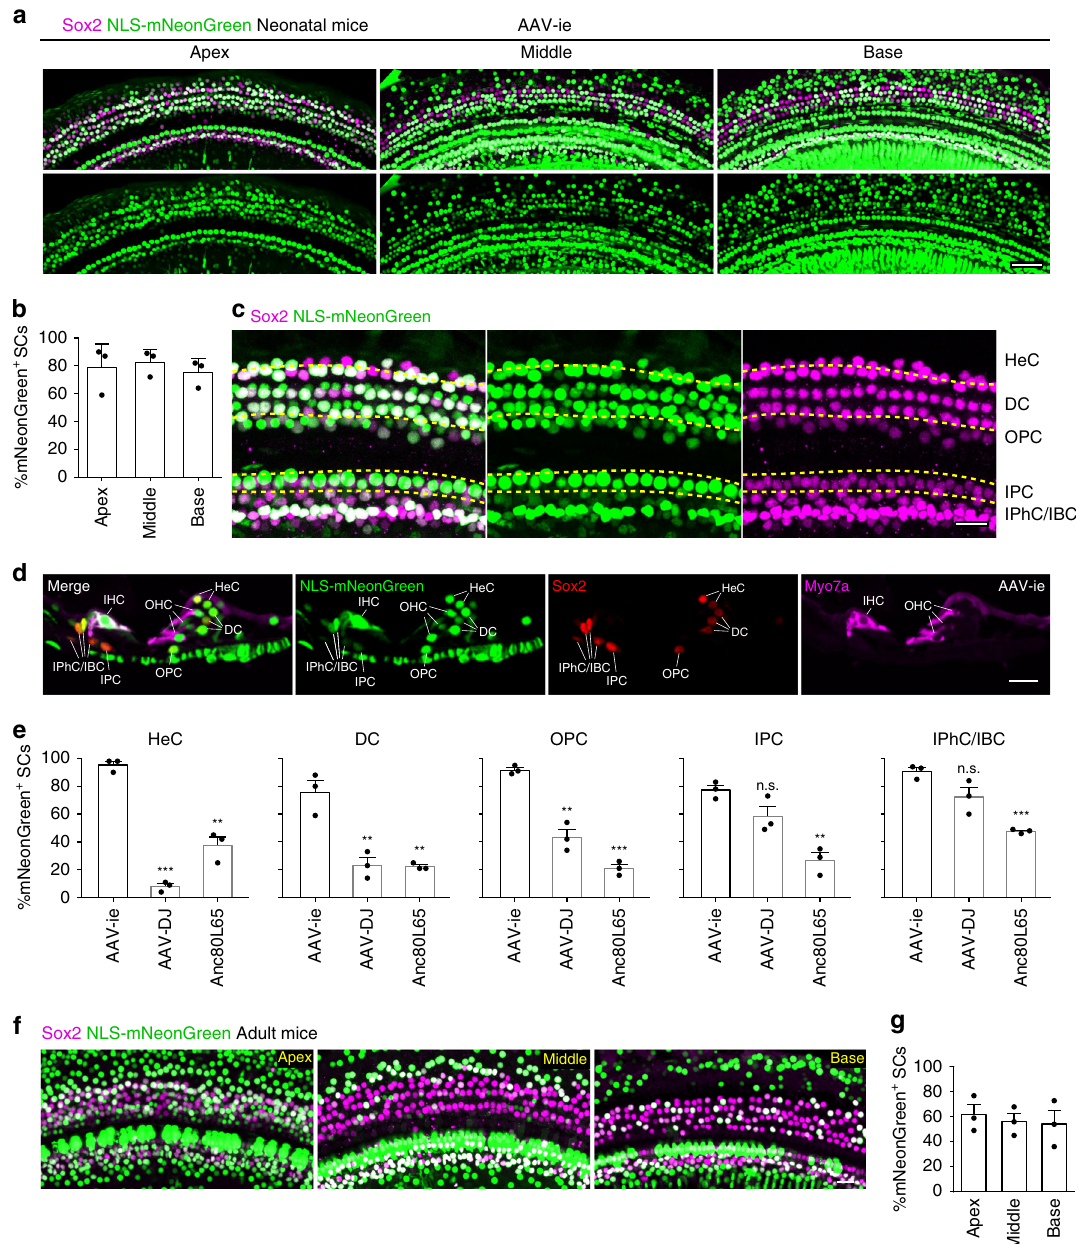
Fig. 2 Adeno-associated virus-inner ear (AAV-ie) ef fi ciently targets cochlear supporting cells in neonatal and adult mice. a Images of the apical, middle, and basal turns of cochlea injected at P3 with AAV-ie-NLS-mNeonGreen (nuclear localization sequence-mNeonGreen) at a dose of 1 × 10 10 genome- containing (particles) (GCs) per ear. Green: NLS-mNeonGreen; magenta: Sox2. Scale bar, 50 µ m. b Percentage of NLS-mNeonGreen-positive supporting cells (SCs) per 100 µ m corresponding to a . Data are shown as mean ± SEM. N = 3 mice. Source data are provided as a Source Data fi le. c Confocal images of Hensen ’ s cells (HeCs), Deiters cell (DCs), outer pillar cells (OPCs), inner pillar cells (IPCs), inner phalangeal cell (IPhCs), and inner border cell (IBCs) in apical turn of cochleae injected with AAV-ie-NLS-mNeonGreen. Green: NLS-mNeonGreen; magenta: Sox2. Scale bar, 20 µ m. d Cross-section of AAV-ie- NLS-mNeonGreen injected cochlea (1 × 10 10 GCs per ear). Green: NLS-mNeonGreen; red: Sox2; magenta: Myo7a (a marker for hair cells). Scale bar, 20 µ m. e Infection ef fi ciencies of Anc80L65, AAV-DJ, and AAV-ie at an equal dose (1 × 10 10 GCs) in HeCs, DCs, OPCs, IPCs, IPhC/IBCs, respectively, are quanti fi ed. Data are shown as mean ± SEM. p Value is calculated by Student ’ s t test. n.s. refers to no signi fi cance. * p < 0.05, ** p < 0.01, and *** p < 0.001. N = 3 mice. Source data are provided as a Source Data fi le. f Representative confocal images of cochlear supporting cells of adult mice injected with AAV-ie- NLS-mNeonGreen. Green: NLS-mNeonGreen; magenta: Sox2. Scale bar, 20 µ m. g Infection ef fi ciencies of AAV-ie-infected SCs in adult mice. Data are shown as mean ± SEM. N = 3 mice. Source data are provided as a Source Data fi le. For neonatal mice ( a – e ), all cochleae were harvested at day 14 after microinjection with 1.5 µ L of AAV stock solution at P3. While for adult mice ( f , g ), all cochleae were harvested 14 days after microinjection at